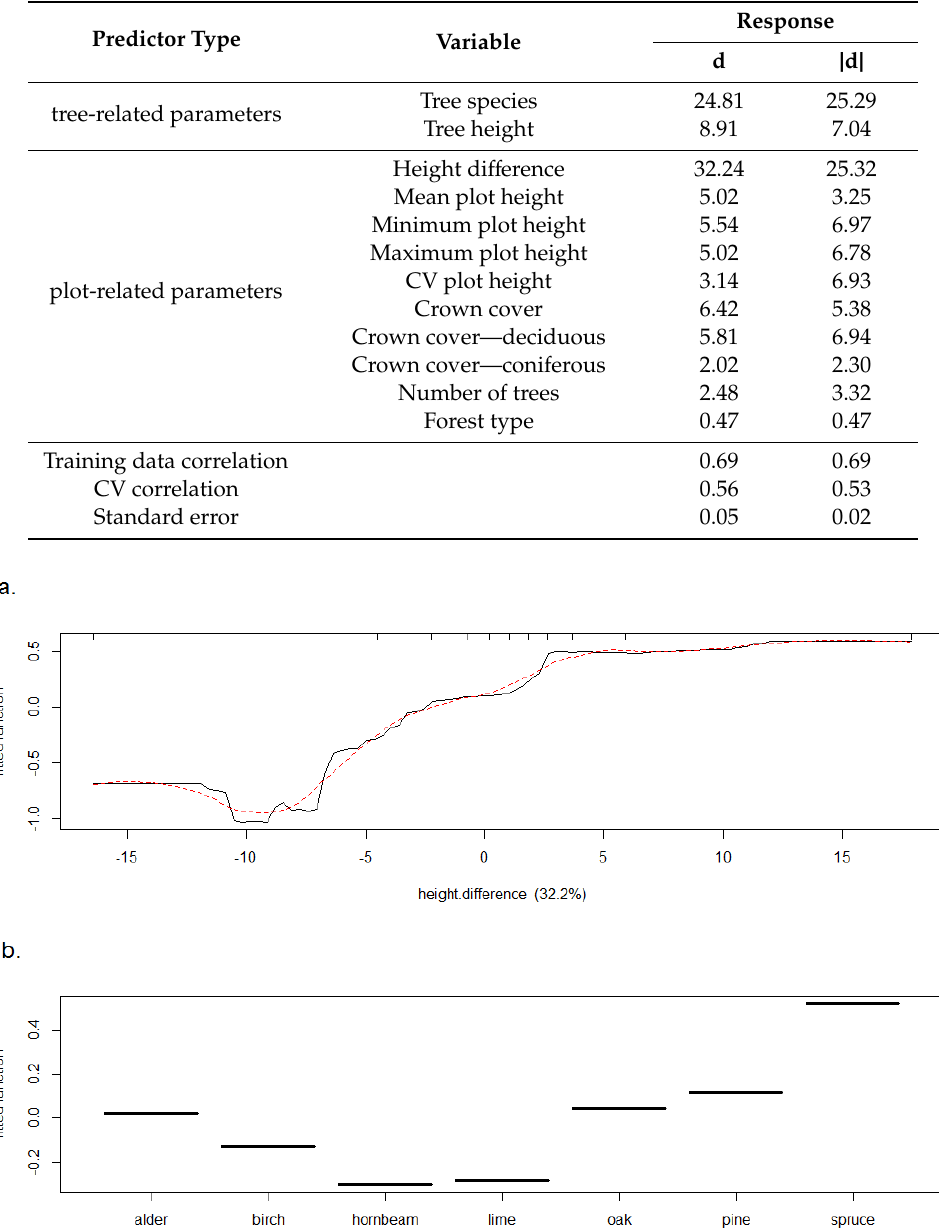
Table 7. Relative contributions (%) of di ff erent variables to discrepancies (d—di ff erence; | d | —absolute di ff erence) between ALS- and DAP-derived heights according to BRT analysis for all BRT models.